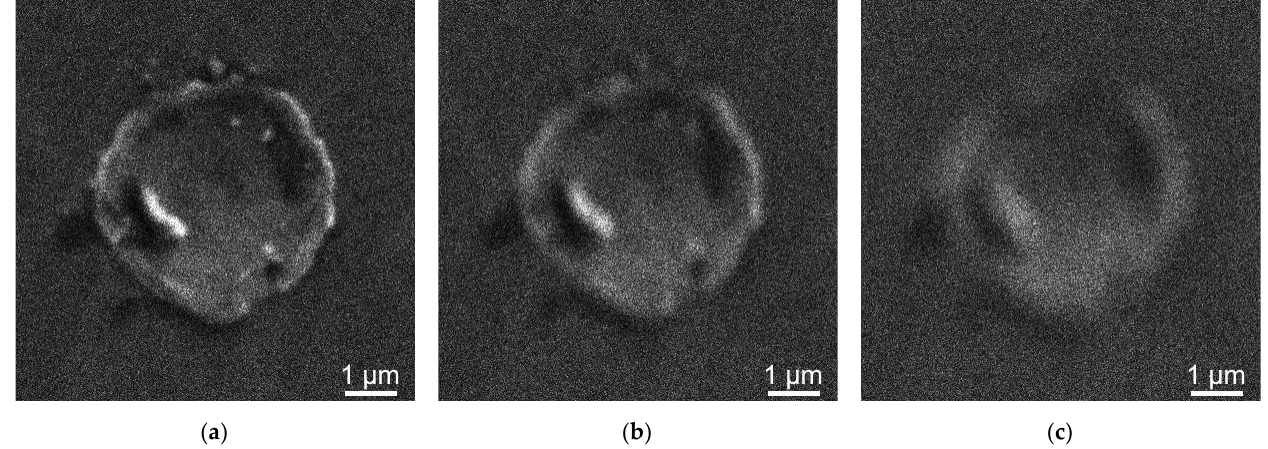
Figure 2. SEM-images of the crater under study: ( a ) in the focusing plane; ( b ) displaced by 50 μ m; ( c ) displaced by 100 μ m. ( c ) displaced by 100 µ